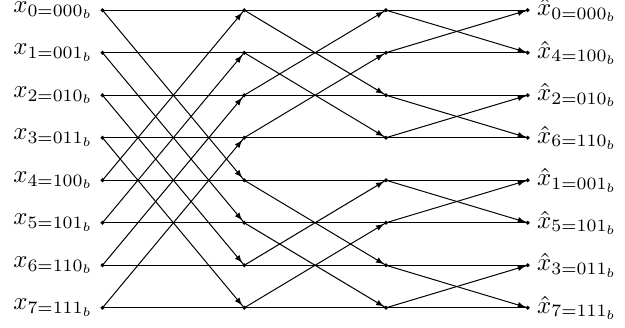
Figure 1: Bit-reversed output order in a radix-2